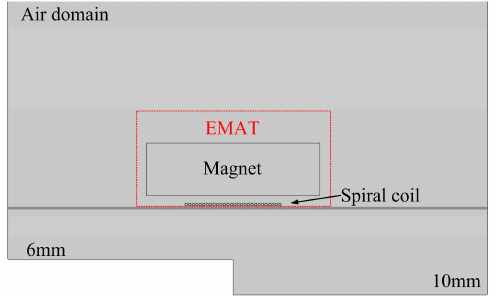
Figure 3. 2D simulation model of the step